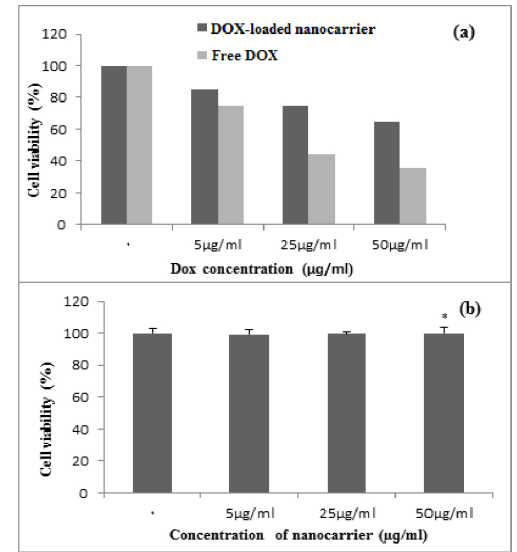
Fig. 6. Survival of MCF-7 cells to (a) free DOX and DOX-loaded nanocarrier with different concentrations of DOX, and (b) nanocarrier. Cell survival was assessed by MTT